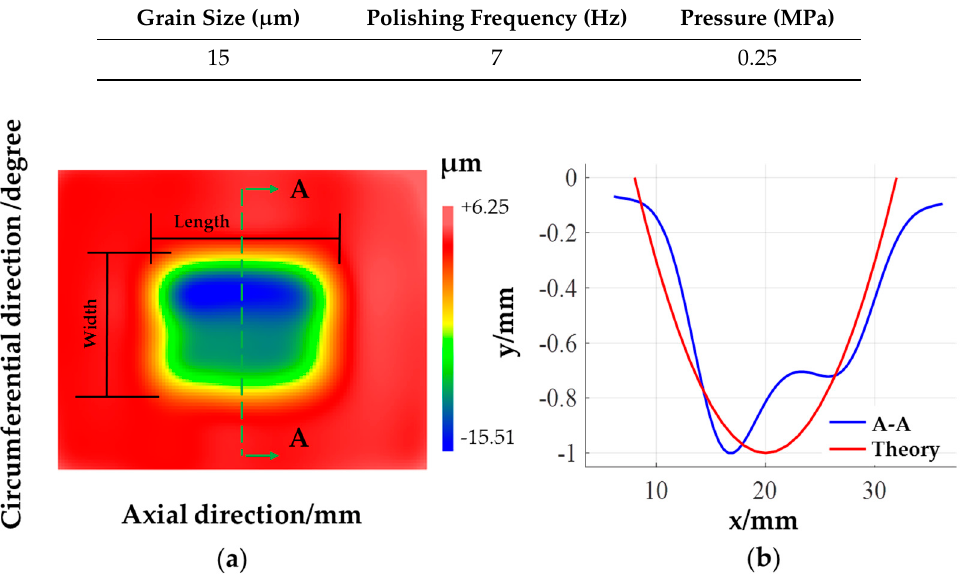
Figure 9. Removal function under optimization parameters: ( a ) Shape of removal function; ( b) normalized contour of the removal